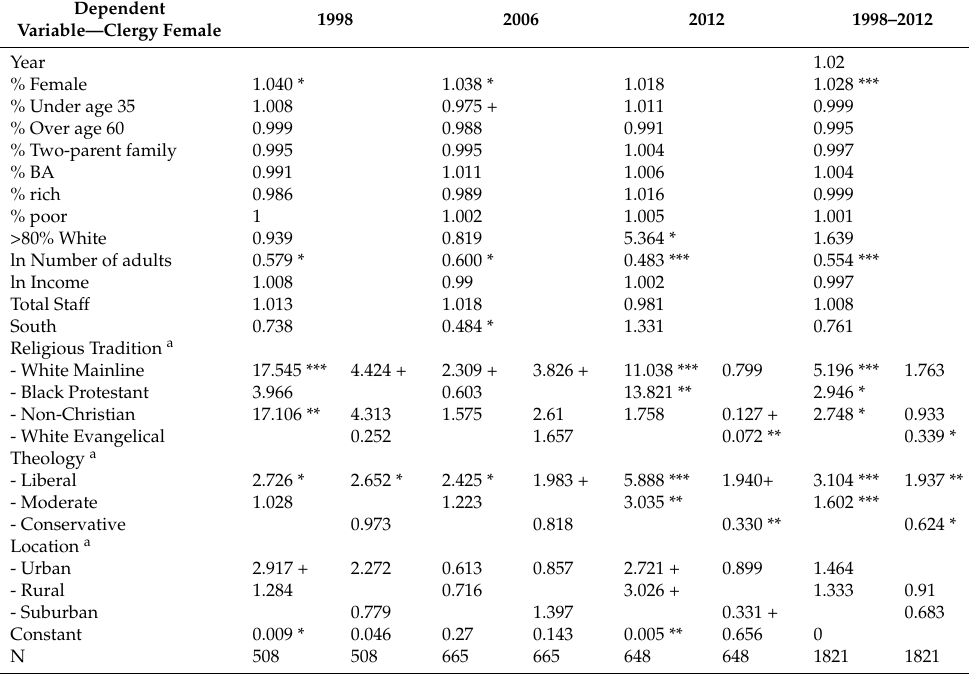
Table 4. Logistic Regression, Congregational Characteristics Predicting Clergy